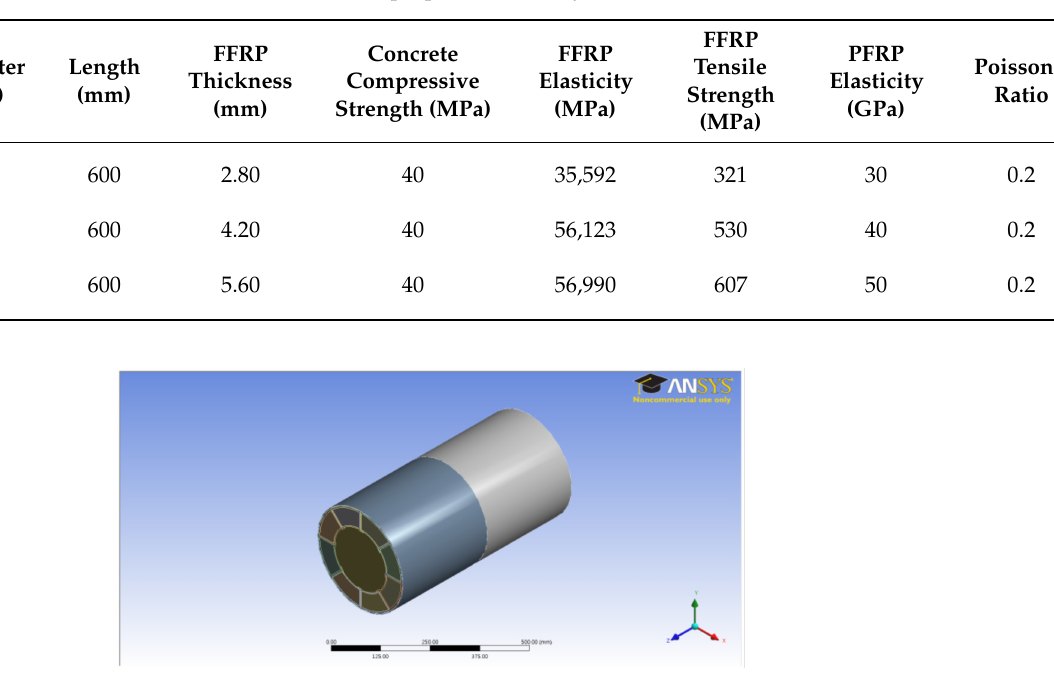
Table 10. Mechanical properties of the hybrid − CFFT.